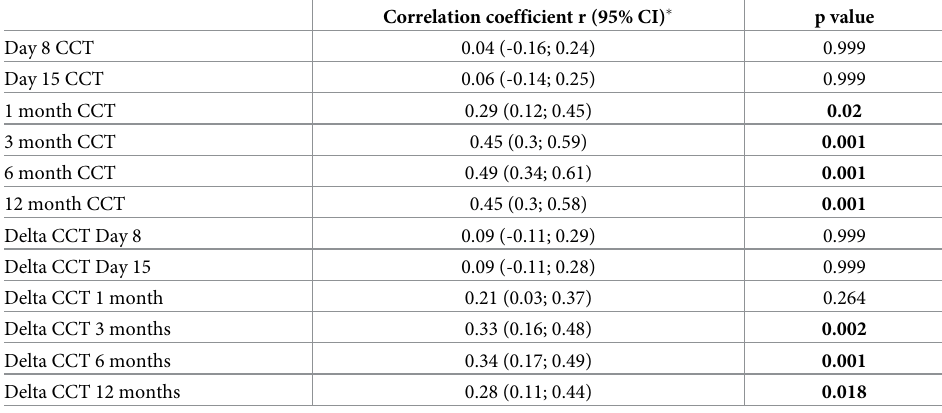
Table 5. Correlations of 12-month BSCVA with CCT at various postoperative